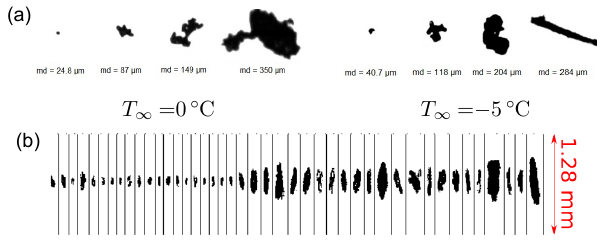
Figure 28. Ice particle images captured at the test section of the Braunschweig Icing Wind Tunnel. (a) images taken by C- HSI probe. (b) images taken by 2D-S probe, MMD = 79µm, IWC = 3.2gm − 3 and T ∞ =− 15 ◦